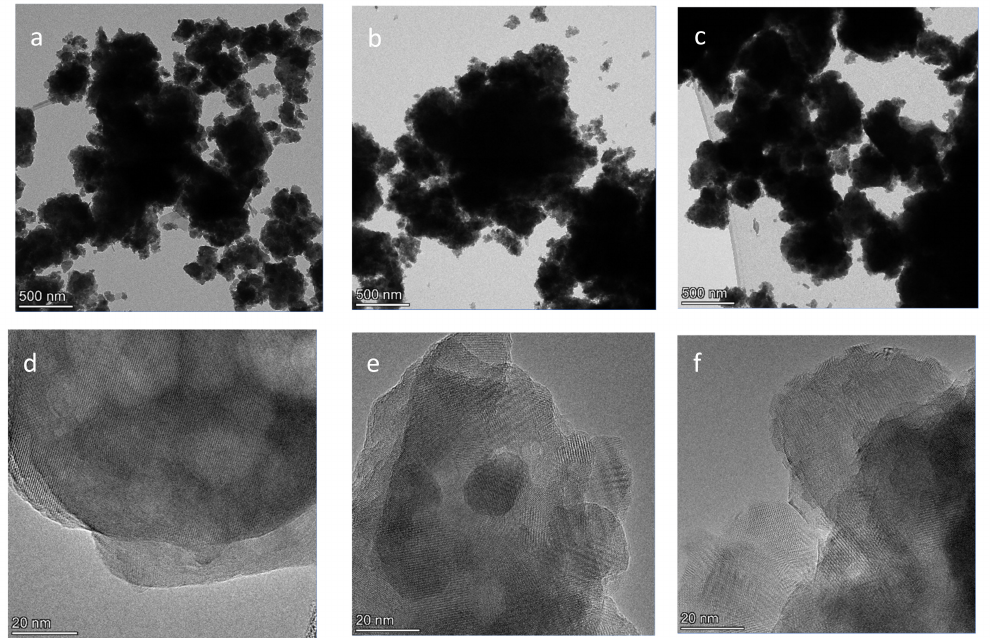
Figure 5. TEM ( a – c ) and HRTEM ( d – f ) images of samples with Ca/P ratios 1.25 ( a , d ), 1.42 ( b , e ), and 2.00 ( c , f ) at different magnification levels.